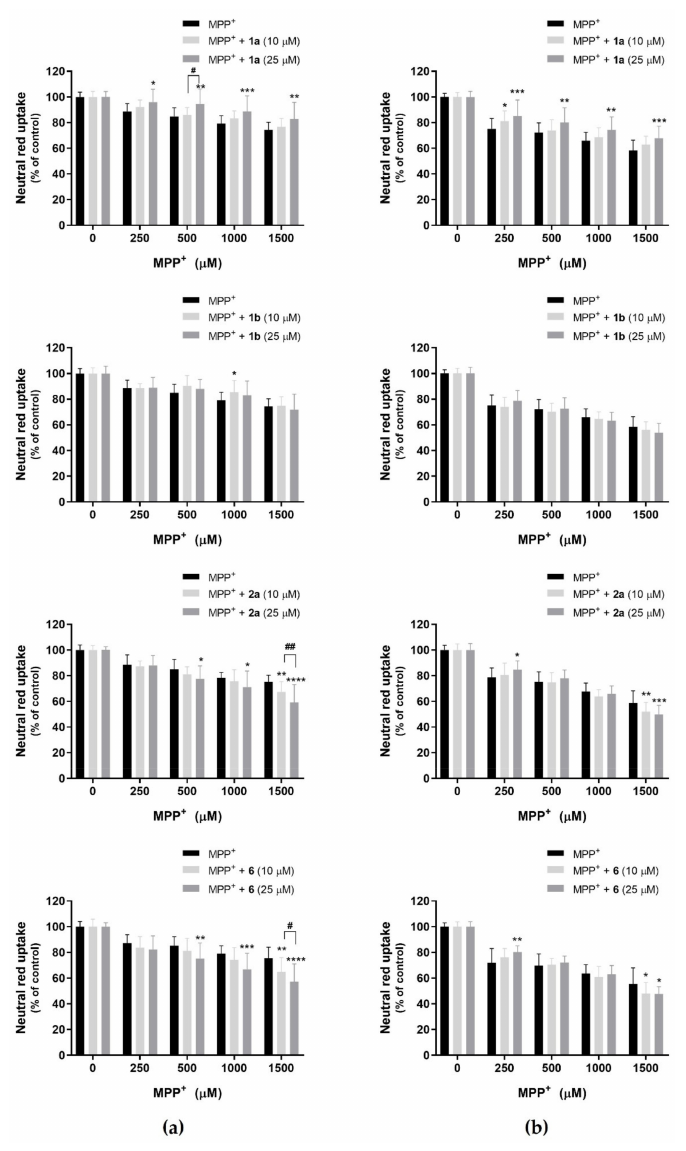
Figure 4. MPP + (0–1500 µ M) cytotoxicity evaluated in differentiated SH-SY5Y cells, in the presence or absence of the most promising fiscalins ( 1a , 1b , 2a and 6 ) (10 and 25 µ M), evaluated by the neutral red uptake assay, 24 ( a ) and 48 h ( b ) after exposure. Results are presented as mean ± SD from 4 independent experiments, performed in triplicate. Statistical comparisons were made using two-way ANOVA, followed by Holm–Š í d á k’s multiple comparisons test. In all cases, p values < 0.05 were considered significant [* p < 0.05; ** p < 0.001; *** p < 0.001; **** p < 0.0001 versus MPP + alone; # p < 0.05; ## p < 0.001 at each MPP + concentration for comparisons between the 10 and 25 µ M concentrations of the tested compounds]. Treatment with MPP + vs. fiscalin concentration interaction (24 h after exposure) for fiscalins 1a : F (8,213) = 1.312, p = 0.2387; 1b : F (8,216) = 1.045, p = 0.4033; 2a : F (8,194) = 2.882, p = 0.0047; 6 : F (8,214) = 2.692, p = 0.0077. Treatment with MPP + vs. fiscalin concentration interaction (48 h after exposure) for fiscalins 1a : F (8,276) = 1.398, p = 0.1972; 1b : F (8,277) = 1.140, p = 0.3364; 2a : F (8,318) = 3.848, p = 0.0002; 6 : F (8,205) = 2.587, p =